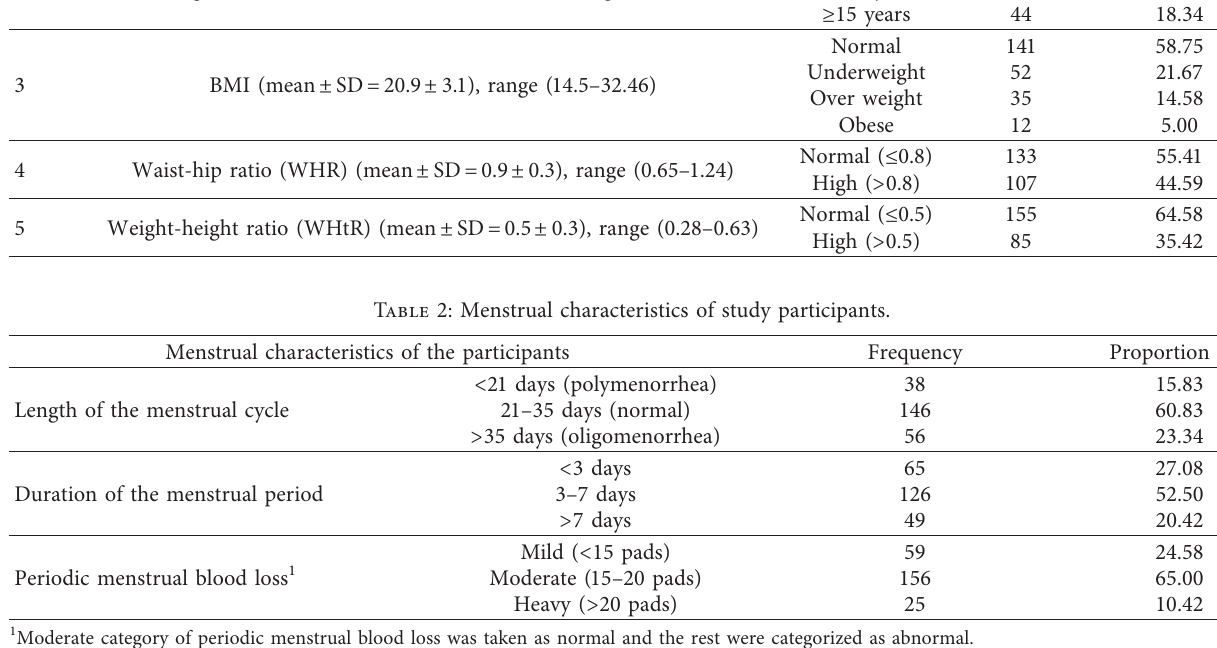
Table 3: Relation of anthropometric parameters with the length of the menstrual cycle by using binary logistic regression analysis. Anthropometric